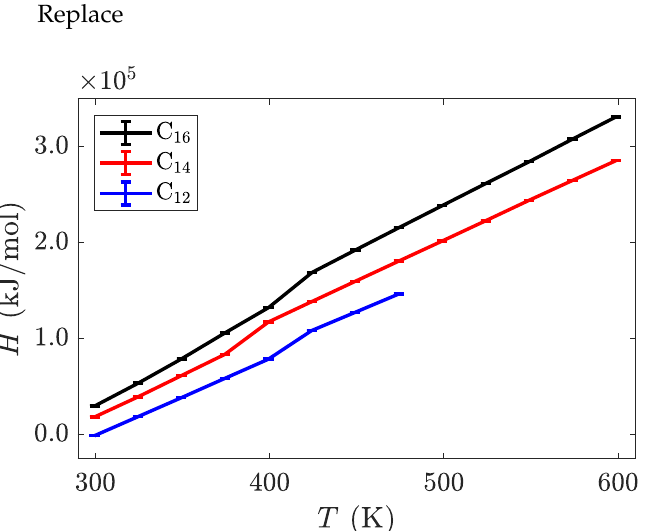
Figure 5. Intrinsic enthalpy as a function of temperature for three different alkyl chain lengths. The phase transitions are less pronounced in this system-wide property, but can be identified by the changes in slope of each line.